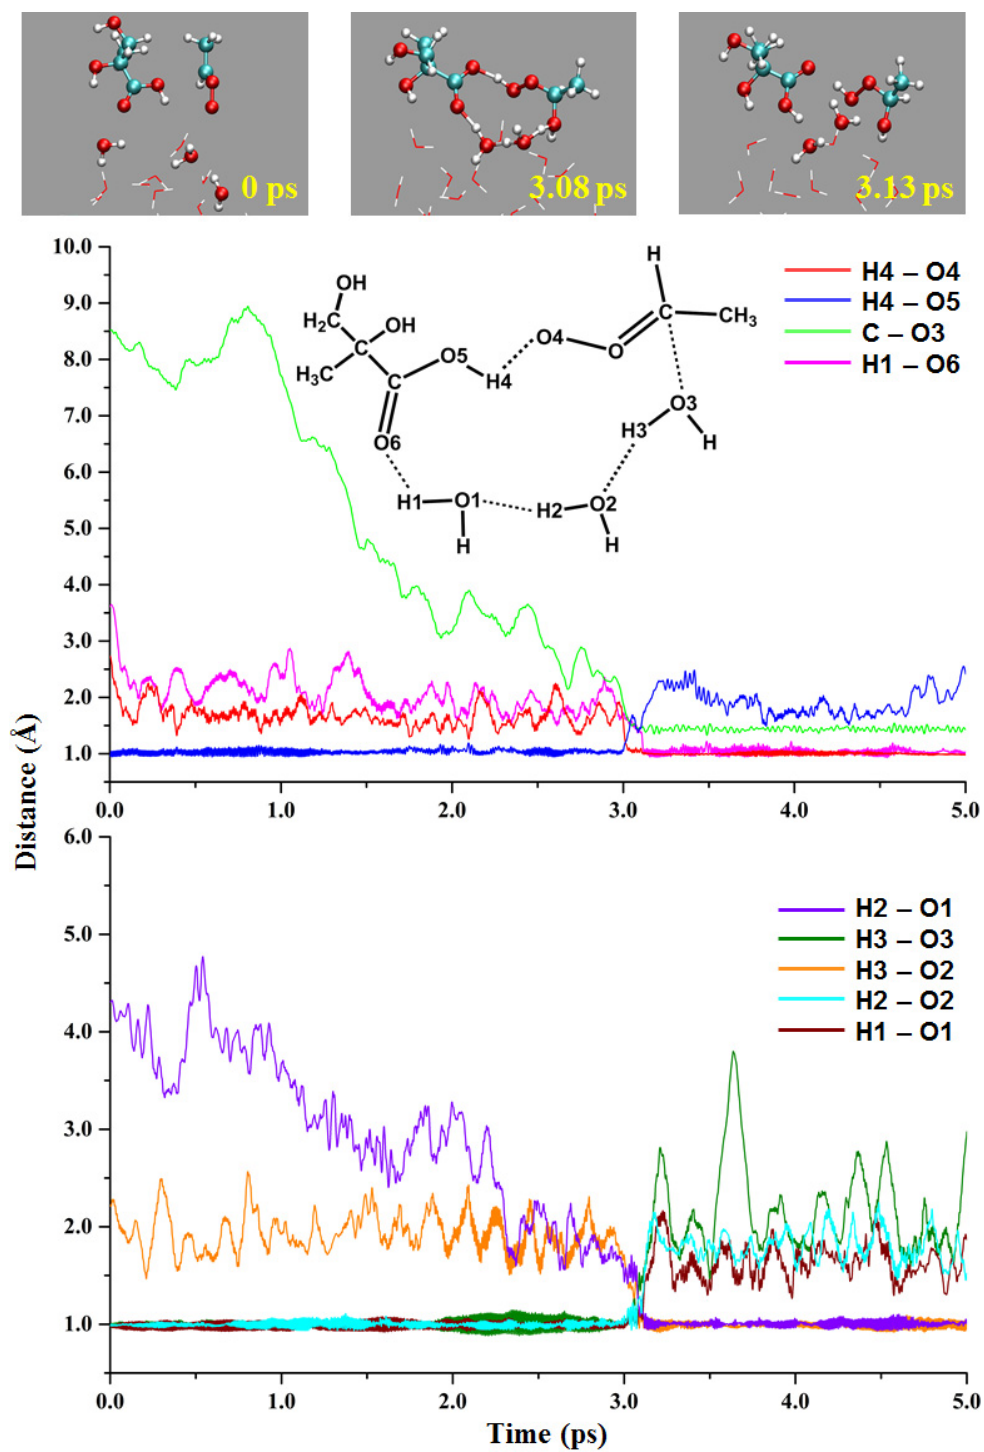
Figure 5. The MGA-mediated hydration of anti -CH 3 CHOO at the gas-liquid interface.